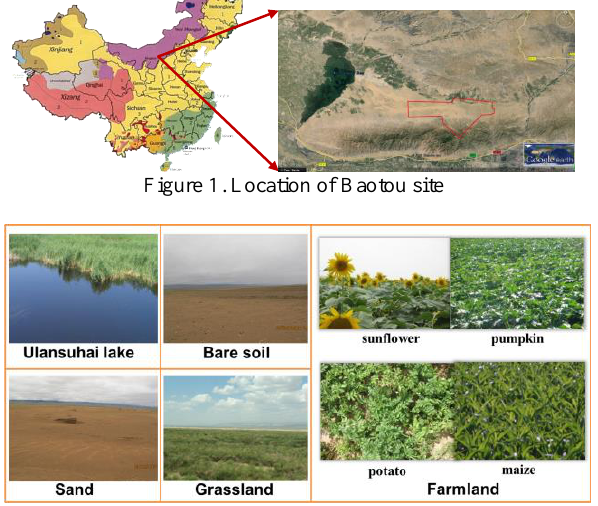
Figure 2. Natural scenes in Baotou site